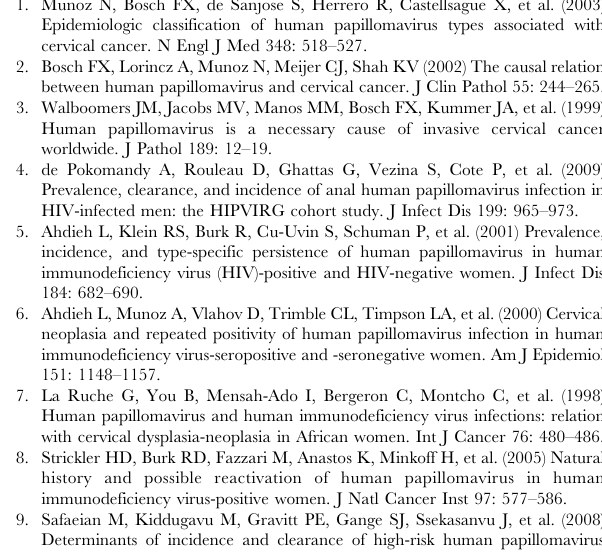
Table S1 Sensitivity analysis of prevalence ratios using alterna- tive partially adjusted log-binomial random effects